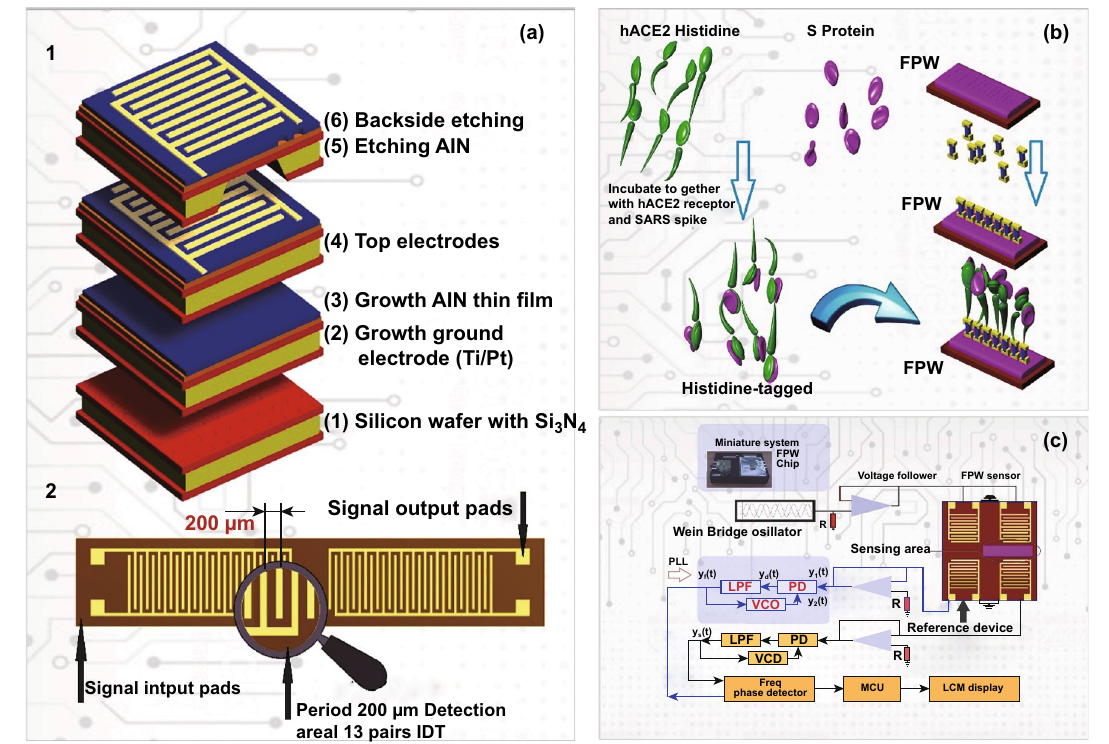
Fig. 8 a Sensor chip for flexural plate wave. (1) Process of microfabrication with the help of technologies of microelectromechanical systems. (2) Top view image of flexural plate wave where the IDT period is equal to 200 µm along with 13 pairs and 1.6 µm is approximately considered for the total thickness. b Diagram of immobilization process represents the fact that an anti‑SARS transfer to the sensor system with immobility by the hybrid protein of S‑hACE2 can provide phase shifts because of utilizing hACE2 and including the protein S to the functionalized biosen‑ sor of flexural plate wave (FPW). c Control procedure of the FPW related to the combined minuscule arrangement for sensing and biosensing purposes. The FPW sensing framework system was constructed of a voltage follower, an FPW device, a Wien bridge oscillator (WBO), and a phase‑locked loop (PLL) that consist of a phase detector (PD), low‑pass filter (LPF) and voltage‑controlled oscillator (VCO), a frequency phase detector, a liquid crystal display module (LCM) display, and a microprocessor. Adapted from Ref. (MCU)